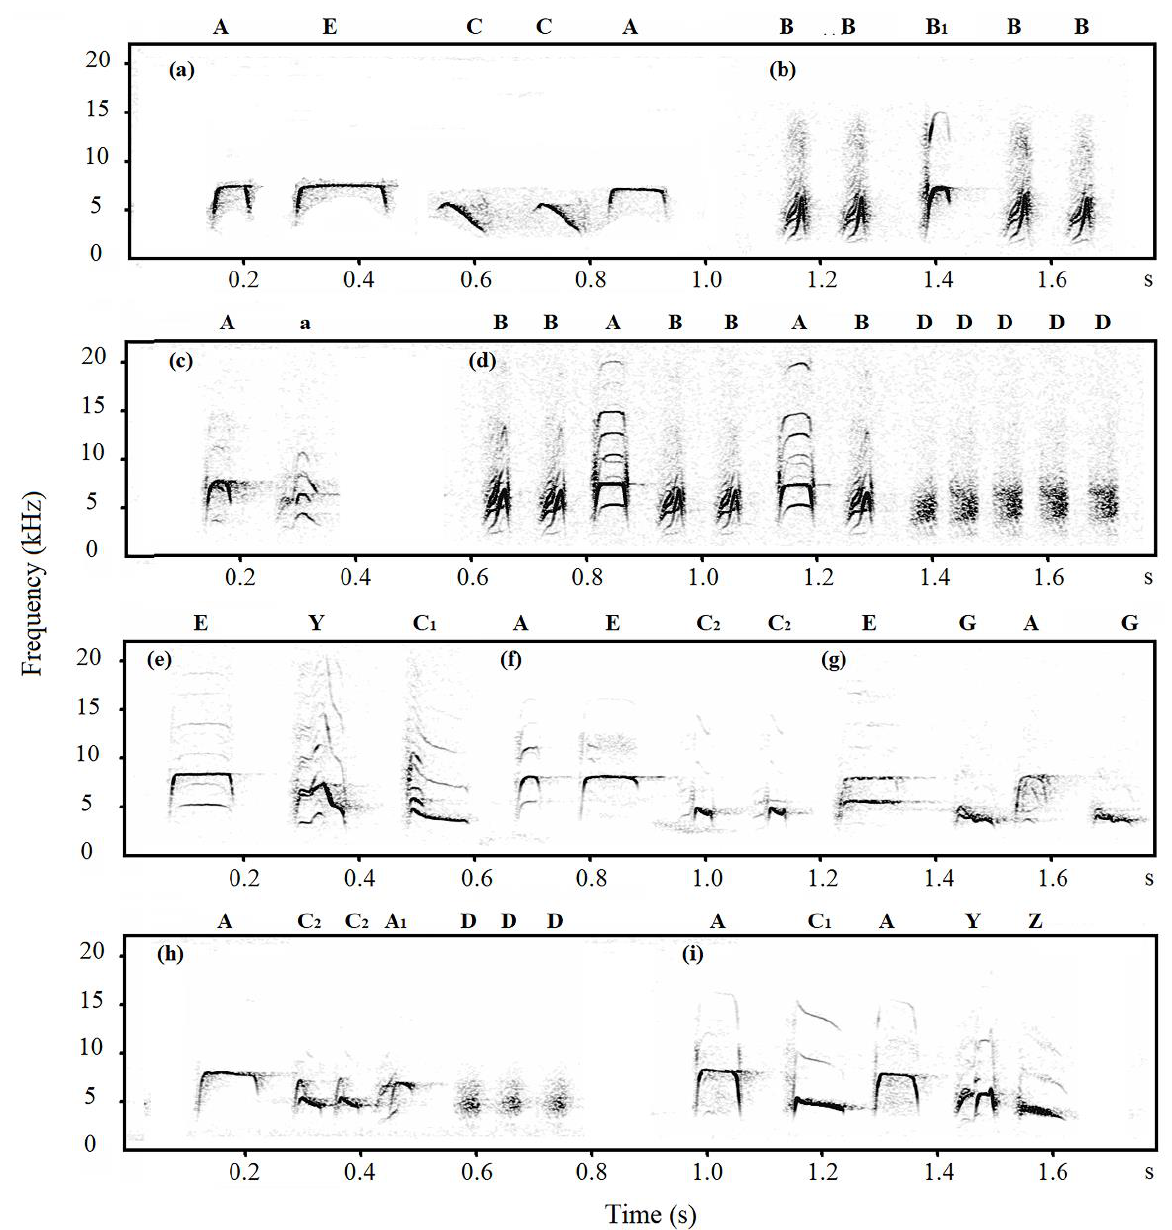
Figure 4. Spectrographic illustration of alarm calls of Hainan-tits (capital letters are notes and lowercase letters are calls).